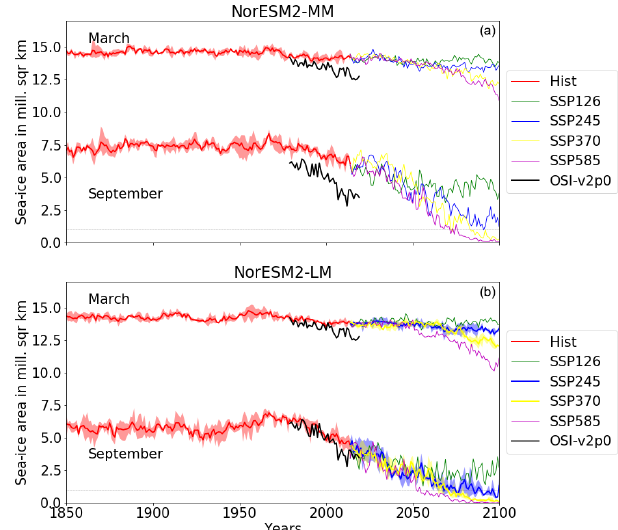
Figure 8. Northern Hemisphere sea-ice area for March and Septem- ber for historical and scenario experiments: (a) NorESM2-MM and (b) NorESM2-LM. Black lines show observations from OSISAF (Lavergne et al., 2019) for the years 1979–2019. Ensemble means, with shades for ensemble range, are shown for both model configu- rations for the historical (1850–2014) and for the SSP2-4.5 (2015– 2100) and SSP3-7.0 (2015–2100) scenarios from NorESM2-LM. The rest of the lines denotes only one